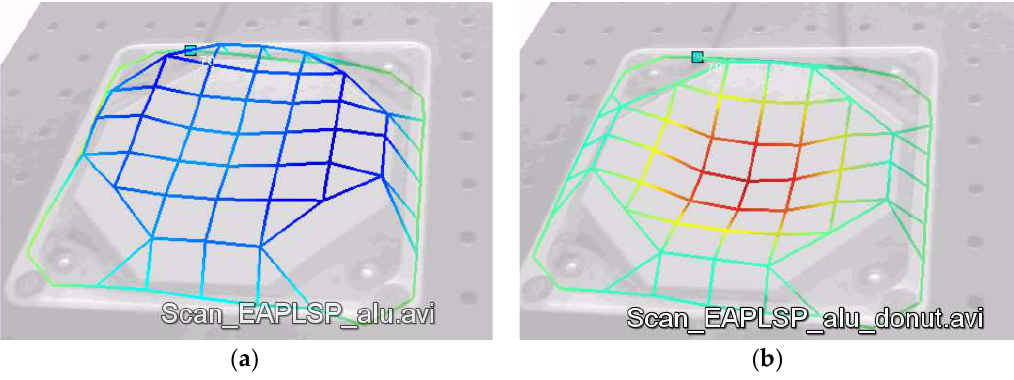
Figure 5. Visualisation of the top electrode displacement at two different driving frequencies: ( a ) 1.6 kHz; and ( b ) 3 kHz.